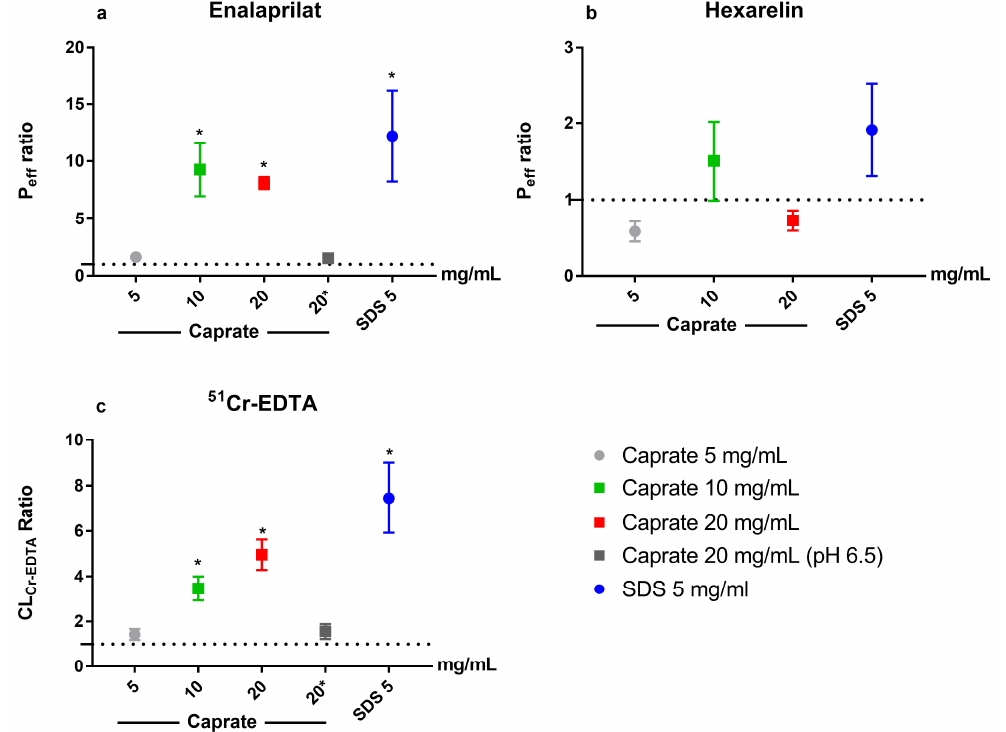
Figure 4. The mean ± SEM lumen-to-blood intestinal effective permeability ( P eff ) ratio of ( a ) enalaprilat and ( b ) hexarelin and ( c ) the blood-to-lumen 51 Cr-EDTA clearance ( CL Cr-EDTA ) ratio, following intestinal perfusions of a control solution for 60 min, followed by a 75-min perfusion of five test formulations containing one permeation enhancer each: The perfusate pH was 7.4, and the permeation enhancers were sodium dodecyl sulfate (SDS) at 5 mg/mL and caprate at 5, 10, and 20 mg/mL. Caprate at 20 mg/mL was also tested at pH 6.5 (dark gray), at which its solubility was 2 mg/mL, instead of 5 mg/mL at pH 7.4. ■ The test formulation as a suspension; ● a solution; and * a significant increase in P eff or CL Cr-EDTA ratio.